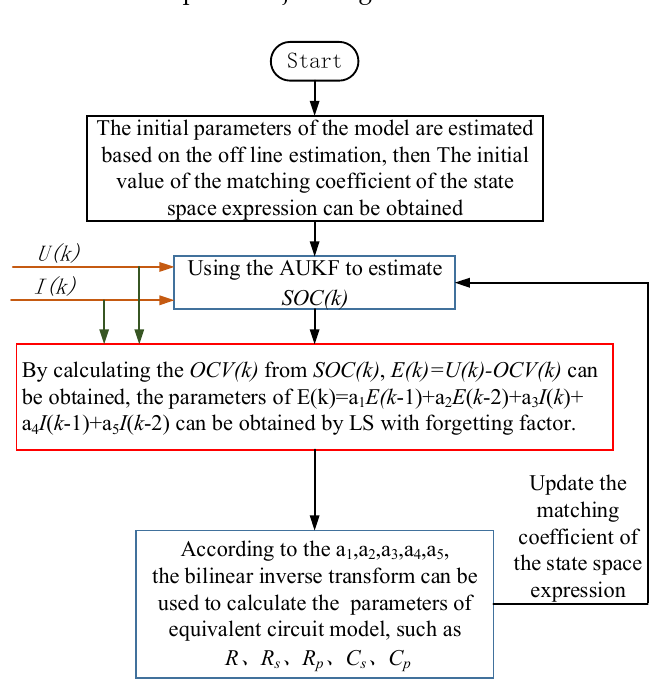
Figure 9. The combination of the LS method with a forgetting factor and the AUKF.